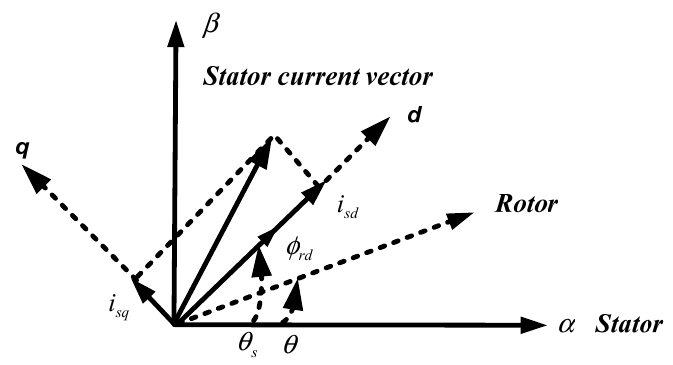
Figure 1. Reference frame for vector